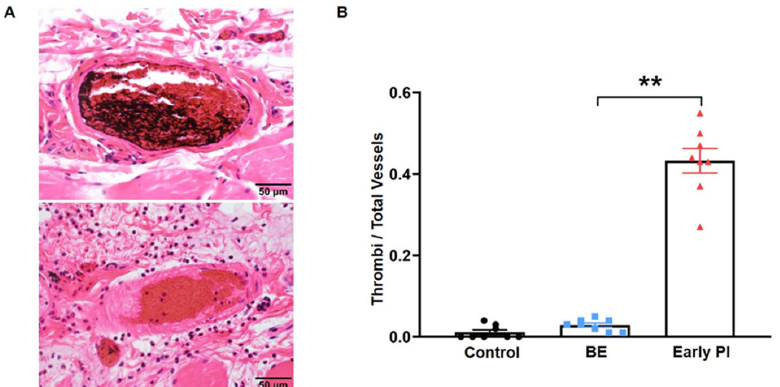
Figure 4. Images of pathological observation and quantification of thrombi: ( A ) the parts with ink perfusion showed post-mortem blood clots. On the other hand, the parts without ink perfusion in the small artery showed thrombus formation post-decompression in the early PI group, which may indicate a cause of circulatory disorder; ( B ) the percentage of thrombus in the three groups. The percentages of arteriovenous thrombus in the total blood vessels of the models were calculated. Values are the mean ± SEM, n = 8 for each group. ** p < 0.001.